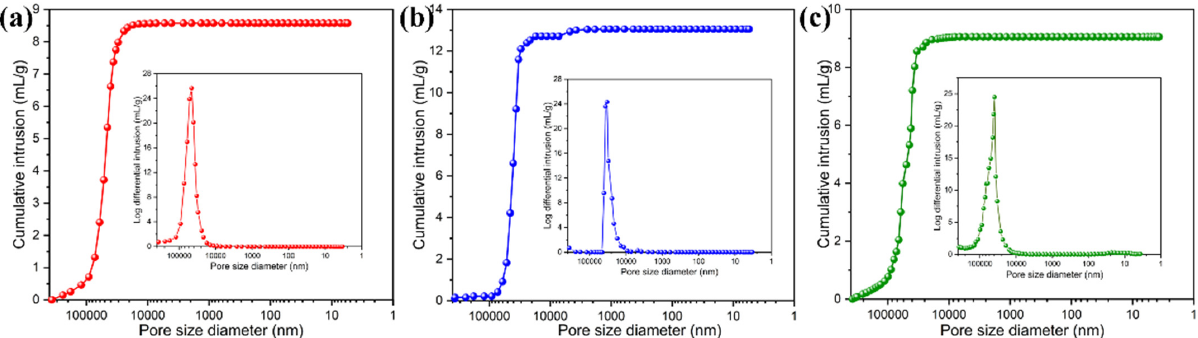
Figure 7. Mercury intrusion and pore size-distribution curves of ( a ) pure PI aerogel film and the PI/graphene/Fe 3 O 4 hybrid aerogel films with a graphene content of 5 wt% and different Fe 3 O 4 contents of ( b ) 0 and ( c ) 6 wt%. Table 1. Porous parameters of PI/Graphene/Fe 3 O 4 hybrid aerogel films with different loadings of Fe 3 O 4 nanoparticles. PI/Graphene/Fe 3 O 4 Hybrid Aerogel